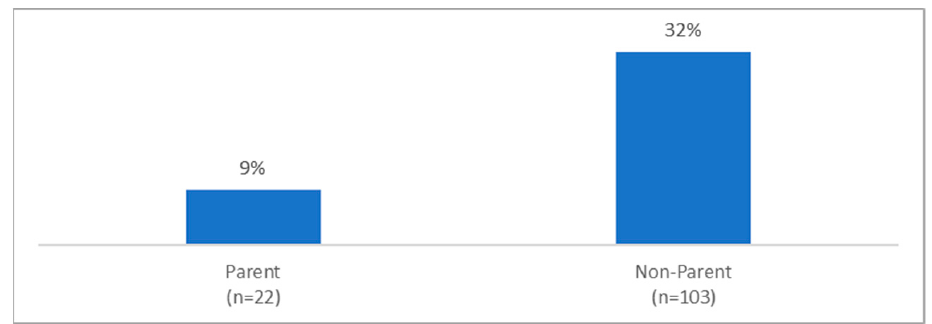
Figure 2. Currently in tourism by parental status.